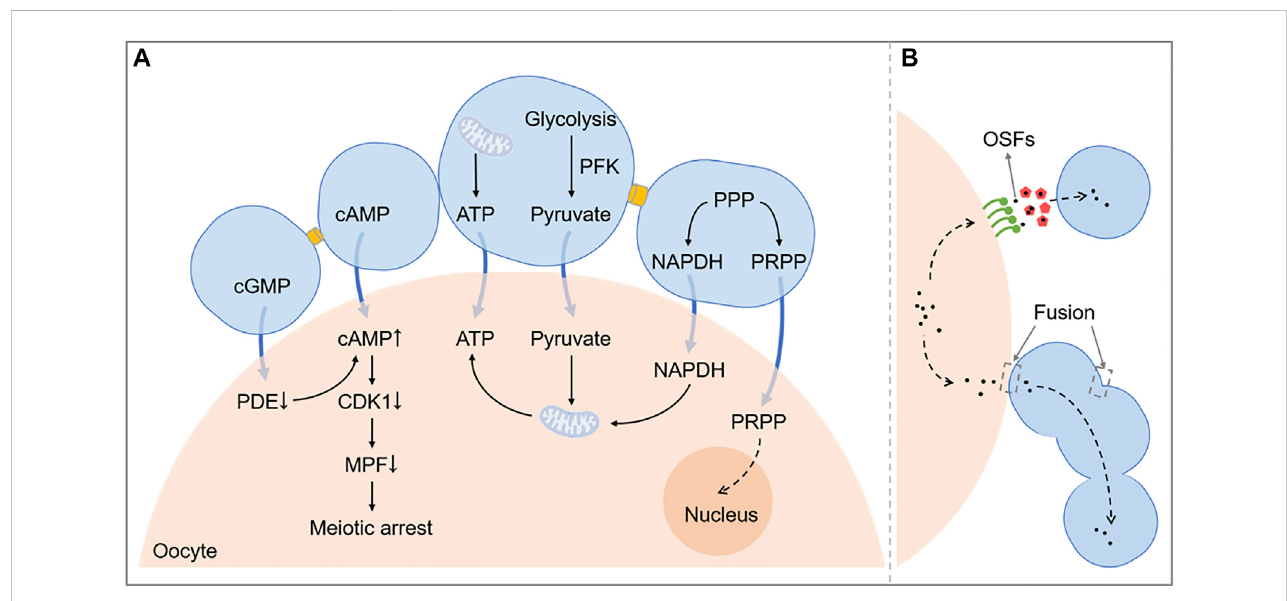
FIGURE 3 A schematic diagram exhibiting the function of intercellular communication in COC. Figure 3A shows related pathways of metabolism and meiosis between theoocyteandcumuluscells.Figure3Bshows thatOSFs canbetransported byEVsor directly getinto cumulus cellsthrough themembranefusion. PPP, Pentose phosphate pathway; NADPH, Nicotinamide adenine dinucleotide phosphate; cAMP, Cyclic adenosine monophosphate; cGMP, Cyclic guanosine monophosphate; CDK1, Cyclin-dependent kinase 1; OSFs, oocyte secreted factors; PRPP, phosphoribosyl pyrophosphate; PDE, phosphodiesterase; MPF, maturation promoting factor; ATP, adenosine